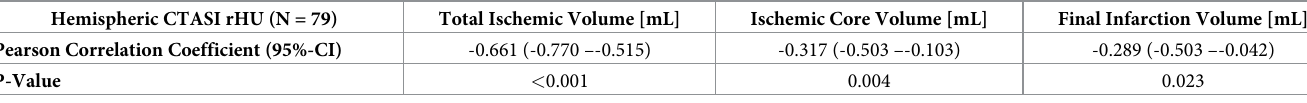
Pearson’s correlation coefficient was calculated for the indicated parameters. Abbreviations: CTASI, CT angiography source images; rHU, relative Hounsfield units; CTP, CT perfusion, CI, Confidence interval. P values < 0.05 indicate statistical significance.